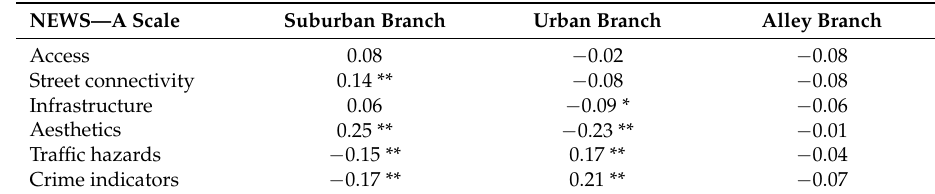
Table 4. Nonparametric correlations between perceived walkability scales (NEWS—A) scales and three branches based on audited walkability